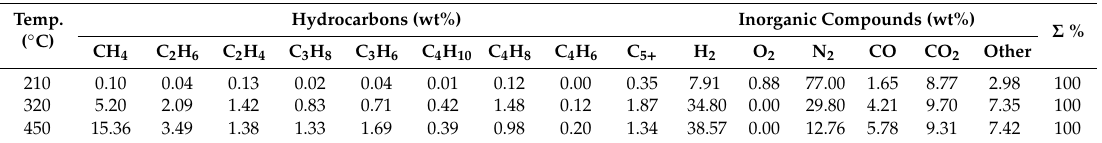
Table 4. Gas composition, preconsumer material, 450 ◦ C.